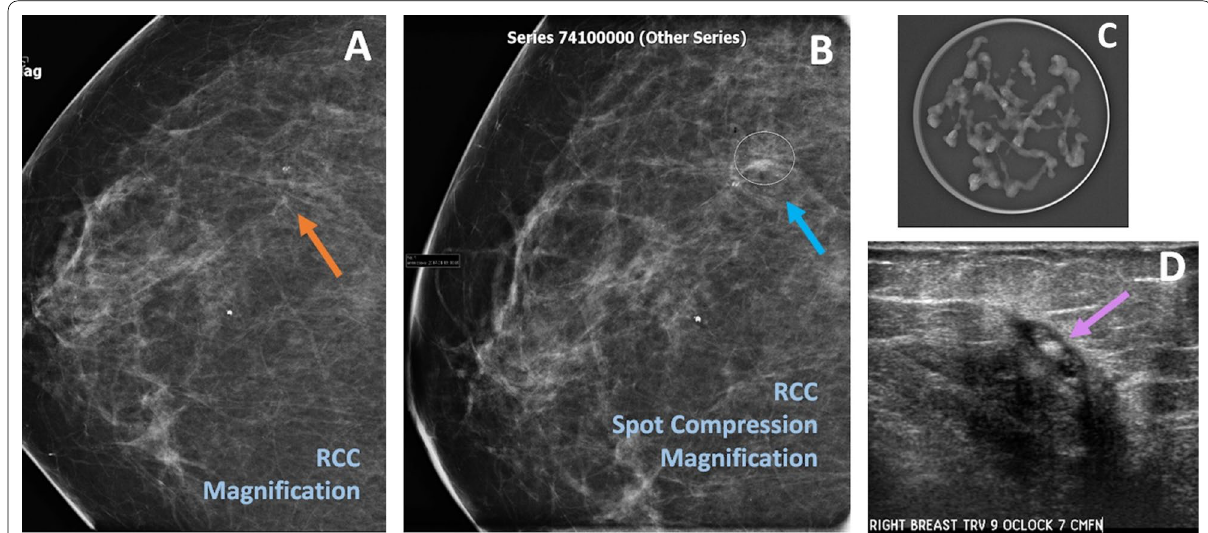
magnification ( A ). Cytokeratin AE1/AE3 Immunostain highlights invasive × magnification ( B ×